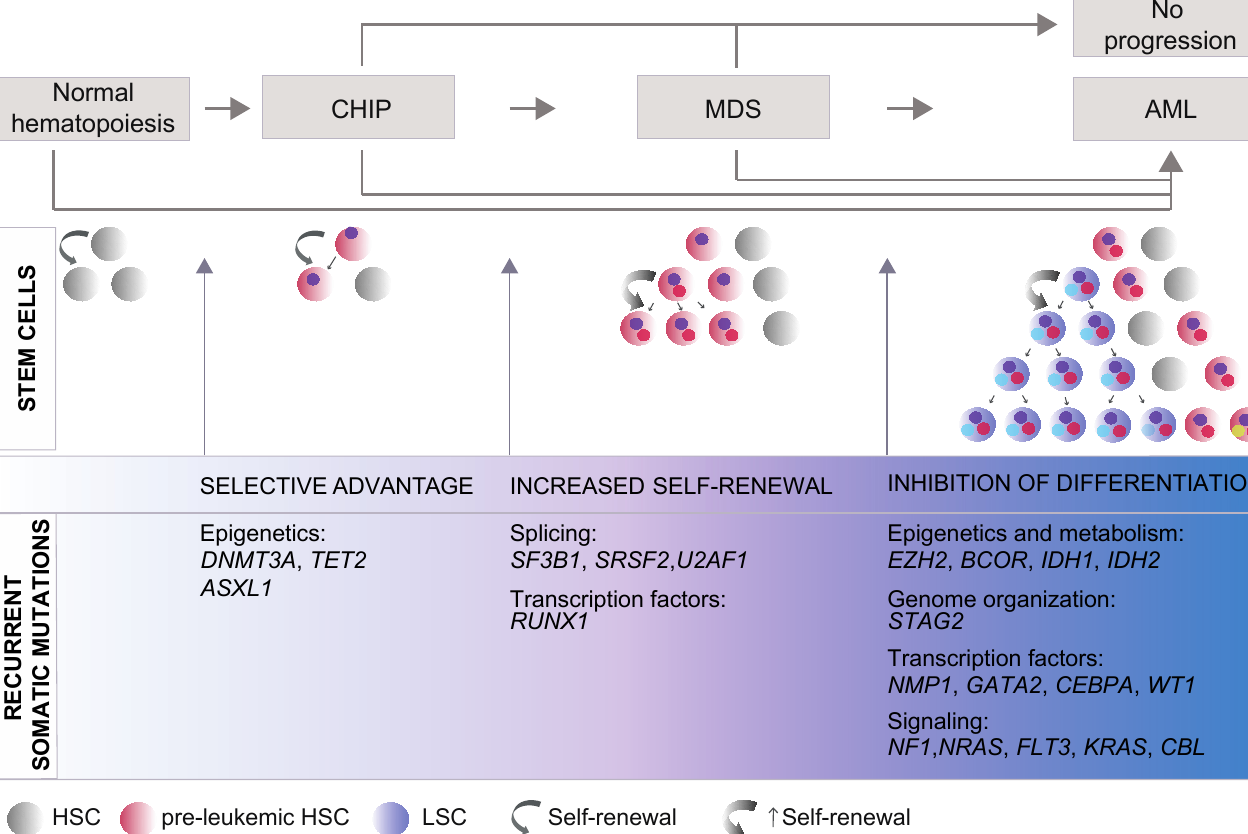
Figure 1. General model of myelodysplastic syndromes (MDS) progression. MDS is a progressive disease, developing through the accumulation of mutations in hematopoietic stem cells (HSCs) or early progenitors that promotes the growth and spread of somatically mutated clones in the bone marrow (BM) and eventually leads to overt clinical disease and to secondary acute myeloid leukemia (s-AML). Distinct phases can be recognized. During the initial phase of clonal hematopoiesis (CH), an initiating driver mutation provides selective advantage and promotes expansion of mutant single clones, without morphological evidence of malignancy nor cytopenia. When the cells carrying the somatic mutation reach 4% of all BM cells (corresponding to a variant allele frequency of at least 2% for the mutation), this condition is defined as CH of indeterminate potential (CHIP). Mutations in the genes involved in DNA methylation, DNMT3A and TET2 , are the most frequent genetic lesions in CHIP followed by mutations in ASXL1 , JAK2 , SF3B1 , and TP53 [16–19]. In the second phase, clonal hematopoiesis progressively expands and becomes dominant in the BM. Accrual of genetic lesions that promote self-renewal/proliferation and inhibit progenitor’s differentiation leads to clonal expansion, dysplasia of progenitors, and mature cells cytopenia. Patients who acquire splicing factor mutations ( SF3B1 , SRSF2 , and U2AF1 ) are at higher risk of developing overt dysplasia and MDS. MDS is clinically defined by a variant allele frequency of the founding mutation of at least 20% of BM cells [4,20]. The leukemic phase (s-AML) is characterized by the acquisition of mutations that inhibit differentiation and typically drive clonal selection and transformation of pre-leukemic HSCs into leukemic stem cells (LSCs), which produce leukemic blasts with aggressive proliferation and expansion abilities. The diagnosis of s-AML is made when the proportion of blast cells increases to 20% or more [4]. Although there is a clear stepwise progression from CHIP to MDS and to s-AML, MDS and AML can also occur due to de novo mutations and CHIP can evolve directly in AML or, in most of the cases, never progress [21,22]. The most frequently mutated genes driving each dysregulated phase are listed and are derived from the following sources: CHIP [16–19,23], MDS [4,13,24], and s-AML [5,25]. Recently, high-coverage whole genome sequence studies of large cohorts of MDS patients identified only 1 driver mutation in 90% of individuals with CHIP [19], progressing to a median number of two to three driver mutations per patient at the onset of the MDS/sAML [25]. While the initial driver mutation occurs in a hematopoietic stem cell capable of self-renewal, mutations associated with clonal expansion during disease progression may occur in progenitor cells, endowing them with self-renewal properties [26,27]. HSC: hematopoietic stem cells; LSC: leukemic stem cells.